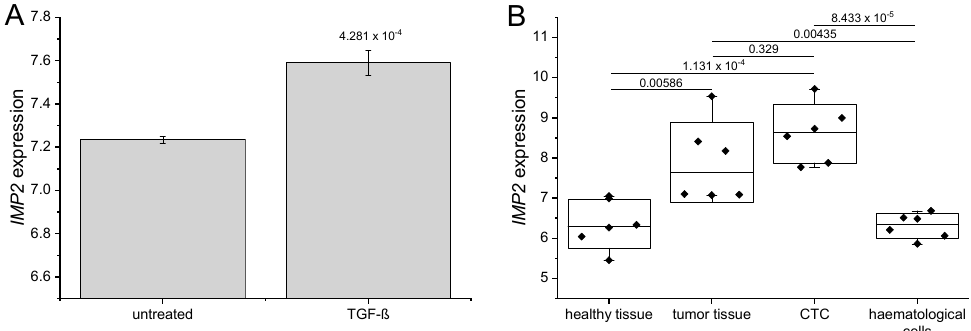
Figure 2. IMP2 is associated with metastasis ( A ) IMP2 expression in Panc-1 cells after EMT induction by treatment with 5 ng / mL TGF beta for 48 h (GEO ID: GSE23952, n = 3); ( B ) IMP2 expression in tumor tissue and CTC compared to healthy tissue and heamatological cells of the same donor as controls (GEO ID: GDS4329).